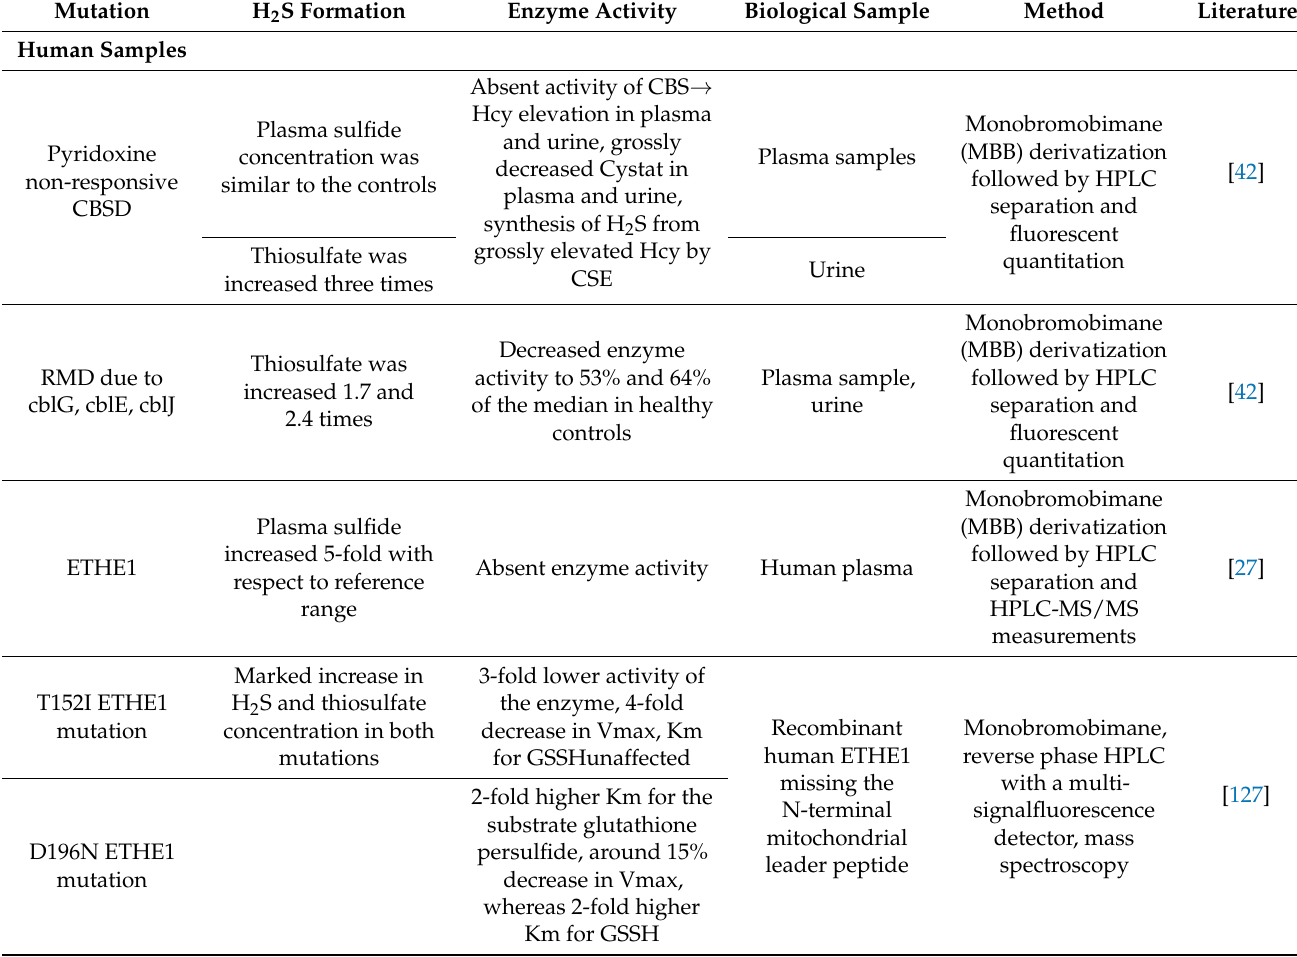
Table 4. Determination of hydrogen sulfide production in genetic diseases of